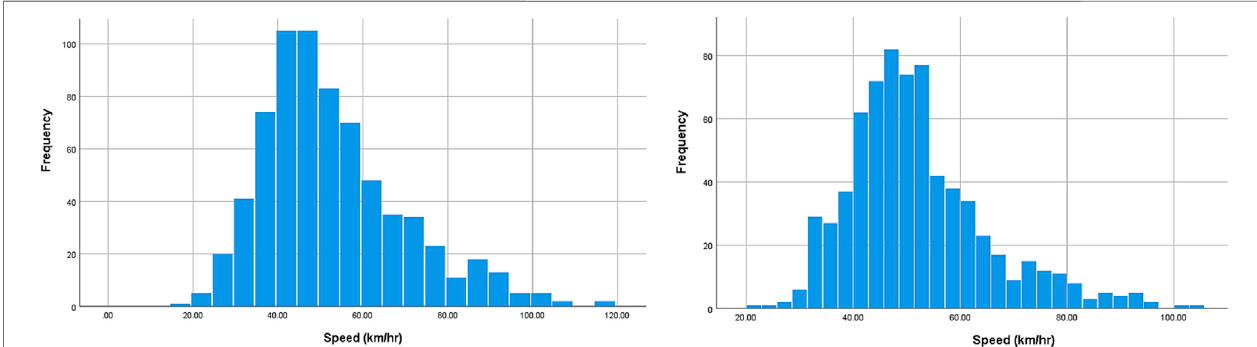
FIGURE 4 | Data distribution, Radar (left), Video